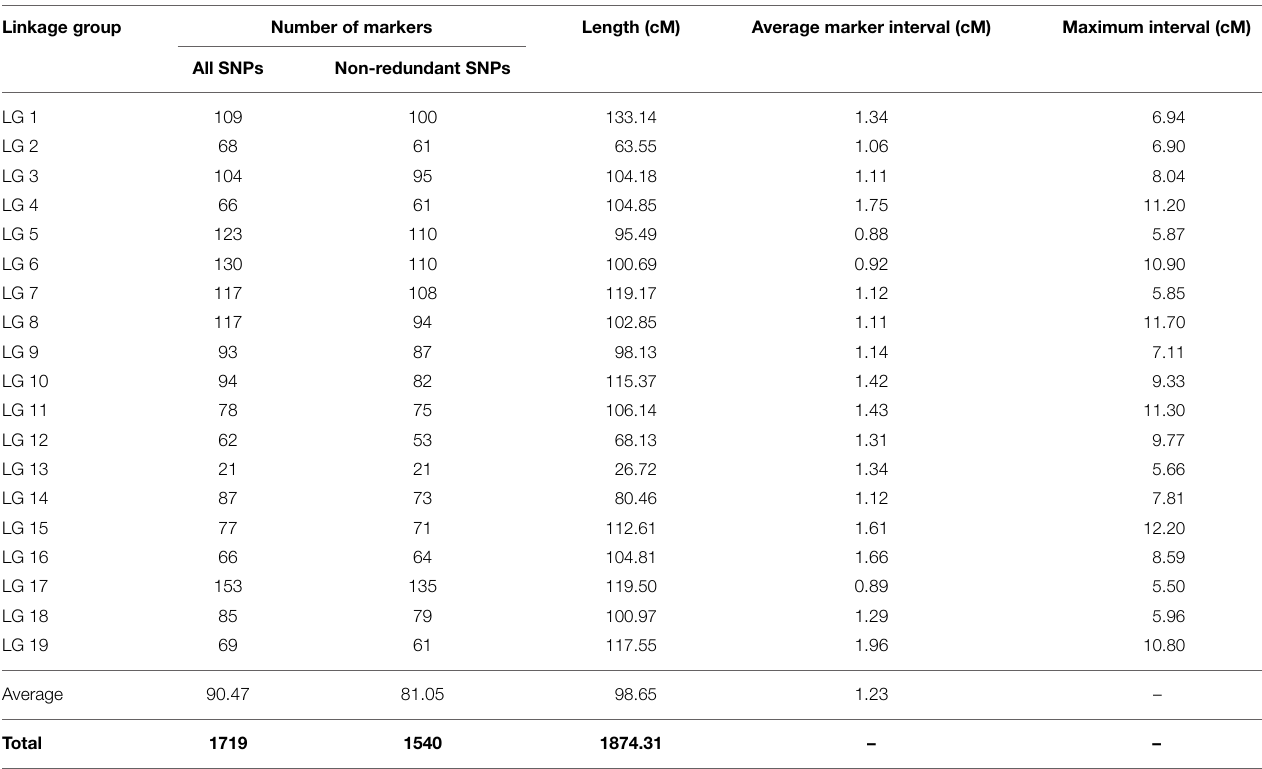
TABLE 3 | Distribution of SNP markers on the linkage map derived from population C (BPM24 × RRIC110). Linkage group Number of markers Length (cM) Average marker interval (cM) Maximum interval